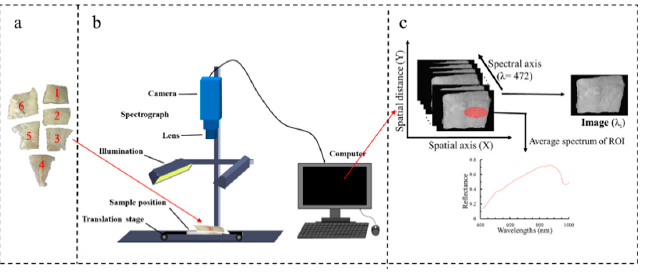
Figure 1. ( a ) Large yellow croaker fillet samples, ( b ) hyperspectral image acquisition, and ( c ) schematic diagram of three-dimensional hyperspectral image.